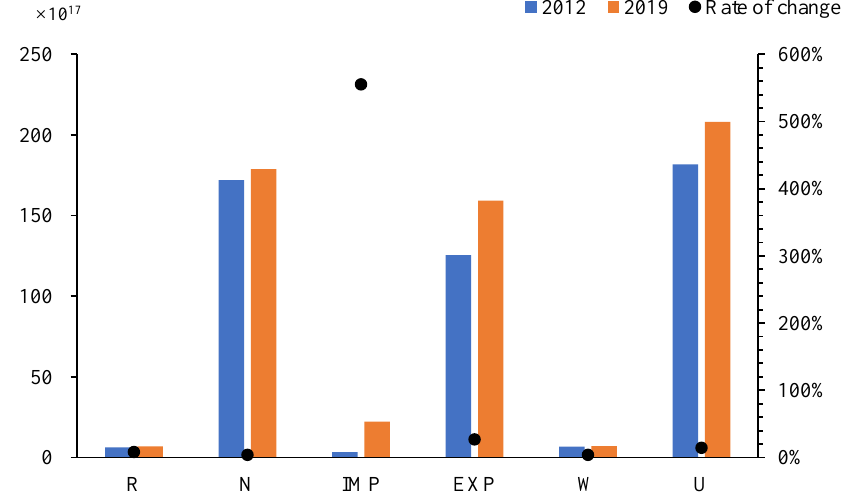
of exporting products increasing. After the establishment of organic farming in 2013, Chehe produced organic eggs, grew morels, and lucid Ganoderma in the greenhouse, which were important resources for Chehe Village to export to other places. Finally, the waste flow